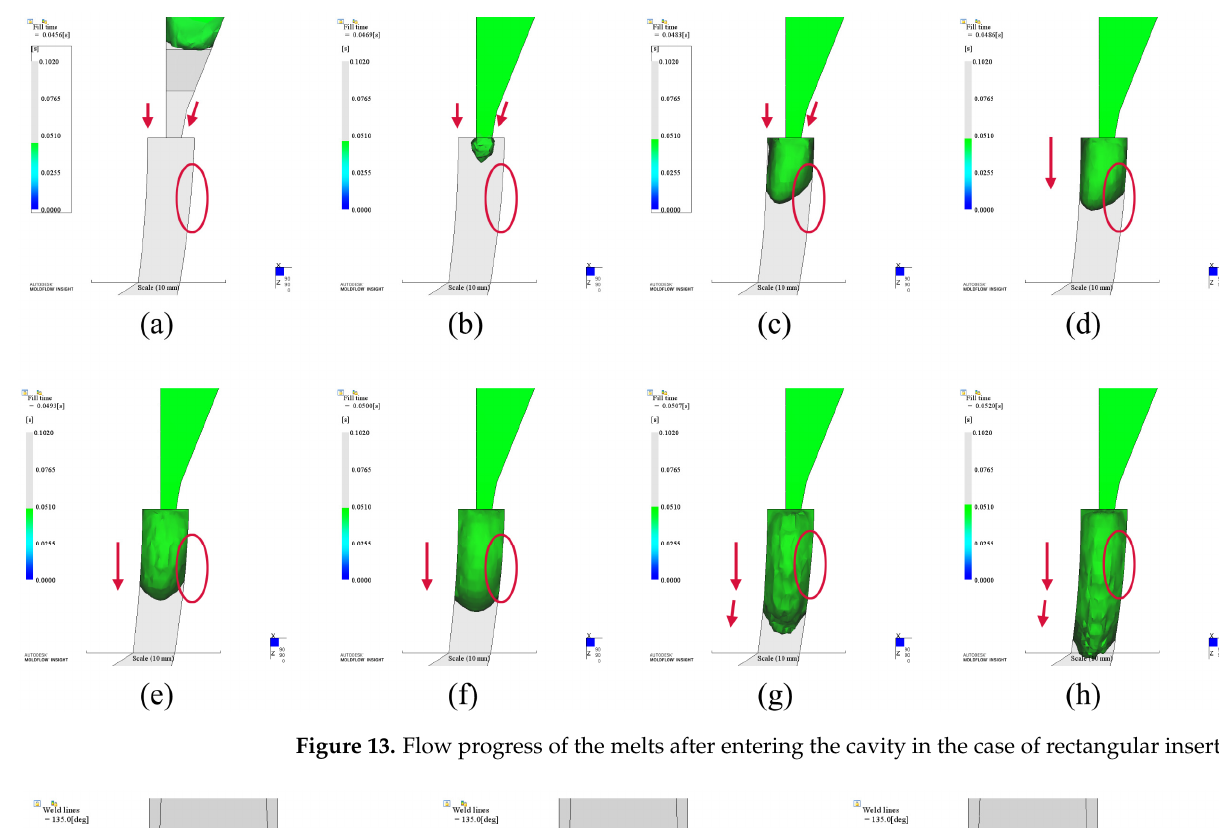
Figure 13. Flow progress of the melts after entering the cavity in the case of rectangular insert.